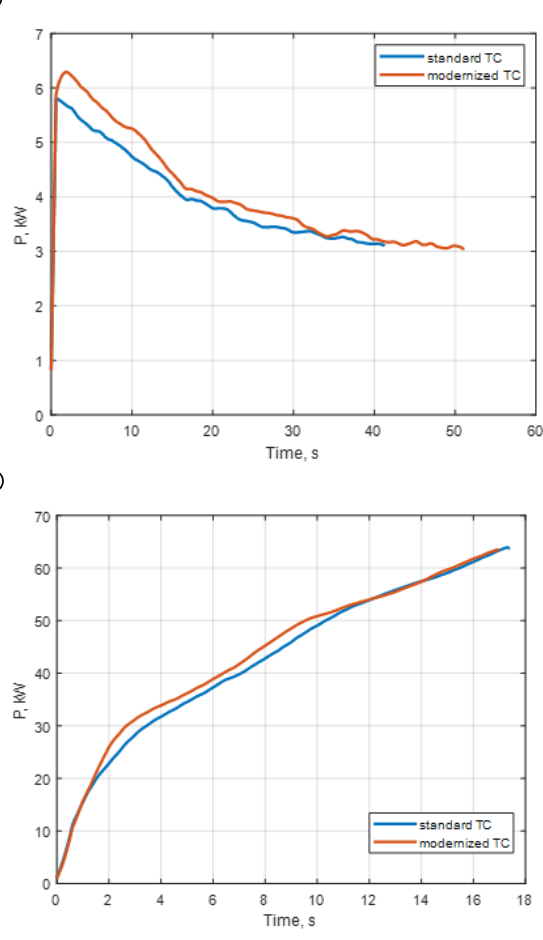
Fig. 5. Comparison of the driving forces (Df) during acceleration with and without the supercharger system for different throttle positions